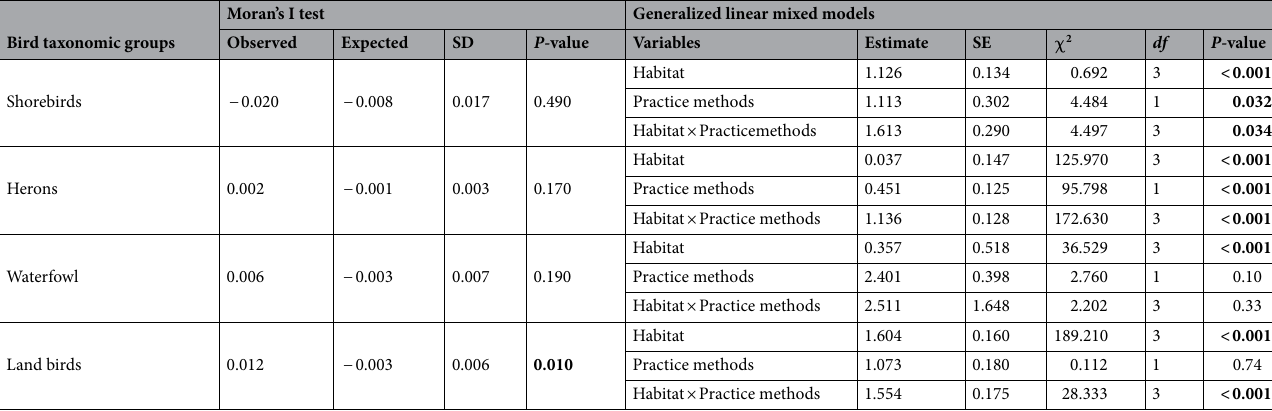
Table 1. Moran’s I test for spatial autocorrelation and results of the generalized linear mixed models used to examine the impacts of cultivation method and habitat type on the abundance of bird taxonomic groups in rice fields. For the analyses of the bird taxonomic groups, the response variable is the number of individuals in each field. The explanatory variables are the habitat type (paddy, levee, ditch, and road) and practice method (eco- friendly and conventional), and the random variables are the survey period and field location. The bold fonts represent statistical significance.